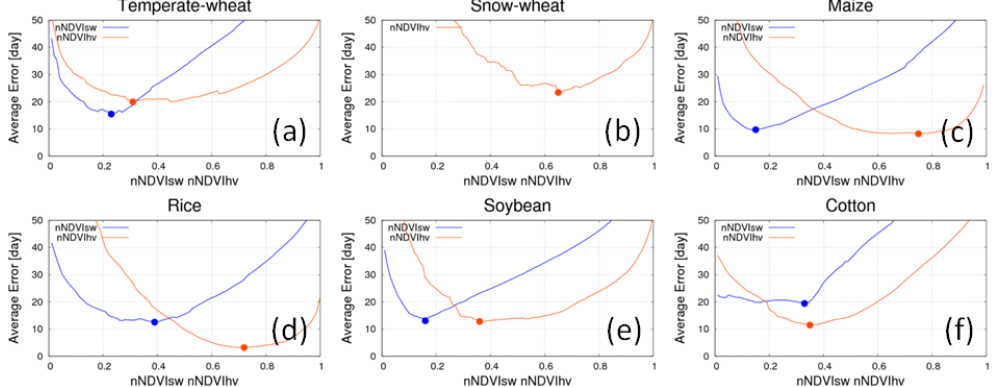
Figure A1. Average error of sowing/harvesting dates (blue/orange lines; unit days) among calibration grids for six crops ( a : temperate-wheat; b : snow-wheat; c : maize; d : rice; e : soybean; and f : cotton). Dots in the figures represent minimized errors and nNDVI sw or nNDVI hv (i.e., the two calibrated parameters in Table 4).